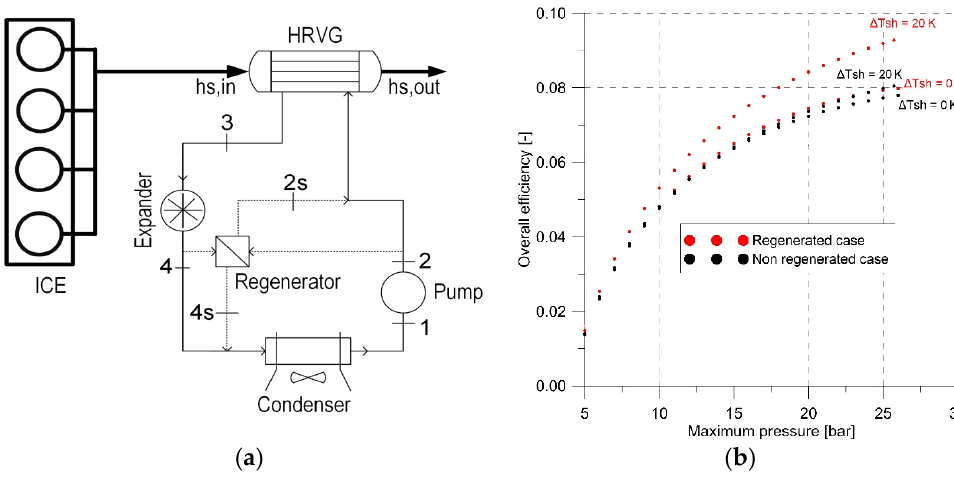
Figure 7. ( a ) layout of a regenerated ORC; ( b ) comparison with base cycle in terms of thermodynamic efficiency as a function of cycle top pressure and superheating degree [112].